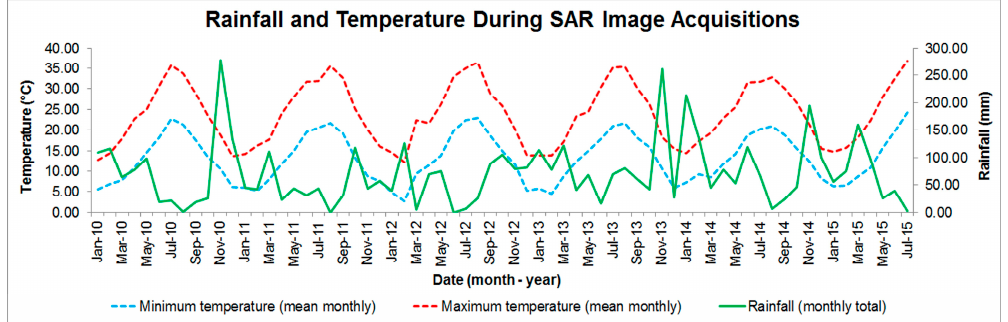
Figure 5. Graph showing rainfall and temperature in time period of Synthetic Aperture Radar (SAR) image acquisitions. The data from which the graph was produced was obtained from the Italian Hydrographic Office of the Lazio region ( Ufficio Idrografico e Mareografico ) [42].